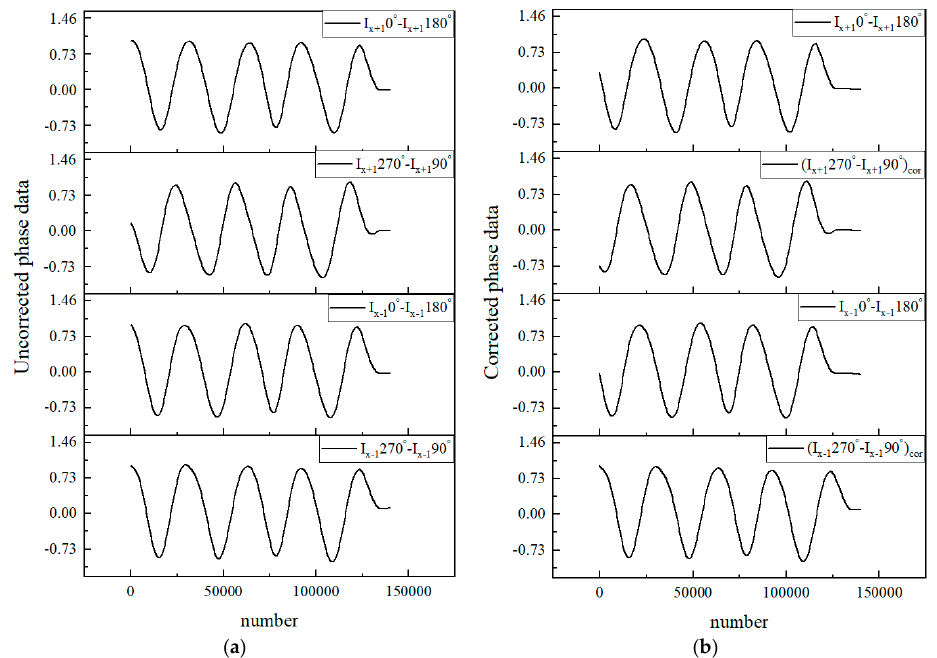
Figure 6. Uncorrected phase data ( a ) and corrected phase data ( b ).